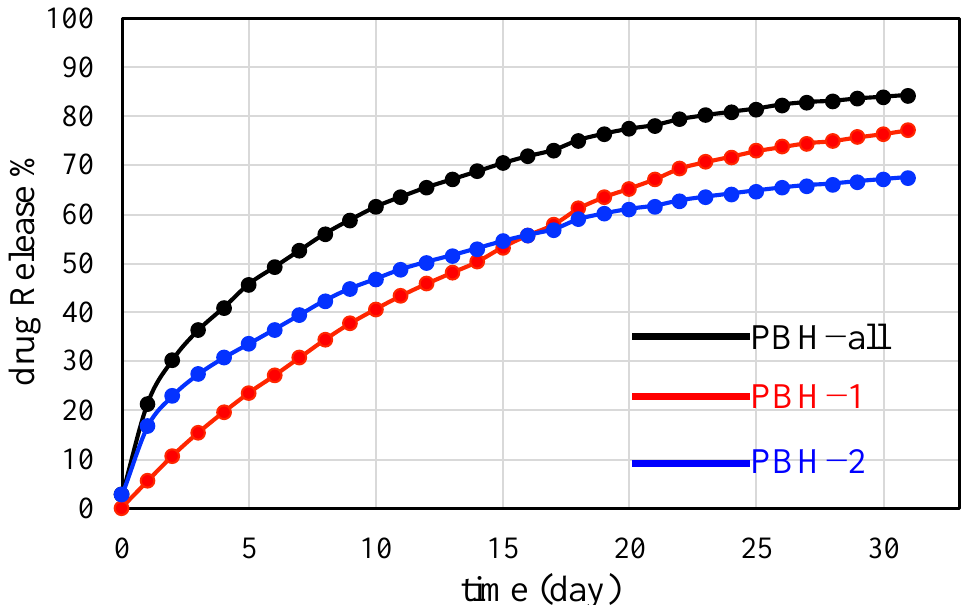
Figure 5. Drug releasing profiles of pluronic biomedical hydrogels. The experiment was contiguously monitored for one month.